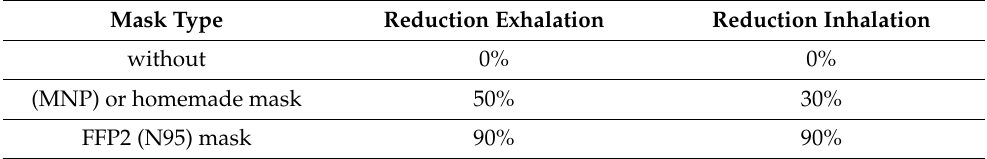
Table 2. Reduction effect through masks